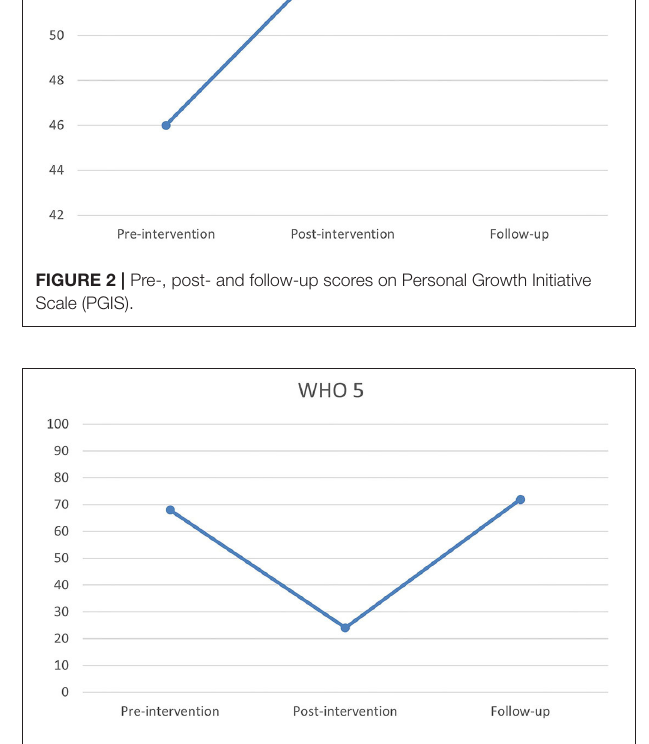
interesting trend seem to show in a visual inspection ( Figure 4